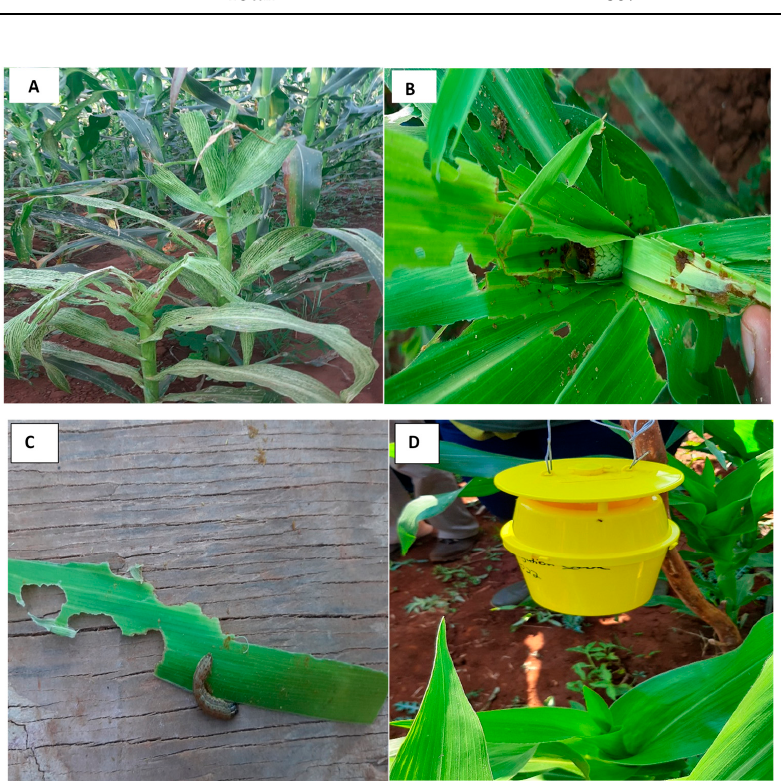
Figure 2. Direct damage on maize leaves by S. frugiperda ( A – C ) and the use of a pheromone trap to monitor thresholds ( D ). Source: pictures taken by Maanda Ramabuli in 2021 . monitor thresholds ( D ). Source: pictures taken by Maanda Ramabuli in